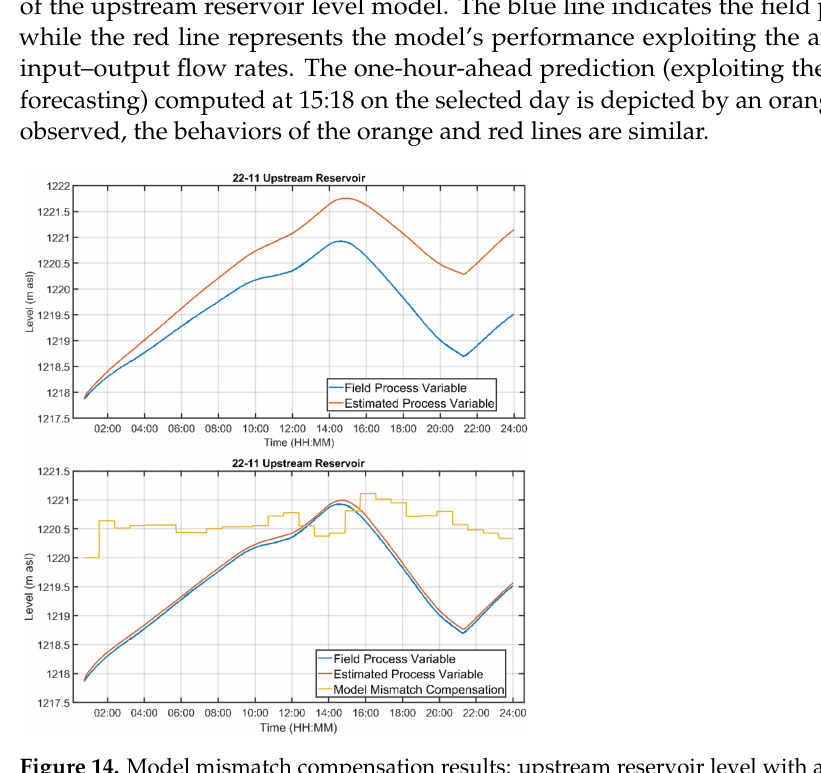
Figure 14. Model mismatch compensation results: upstream reservoir level with and without model mismatch compensation.